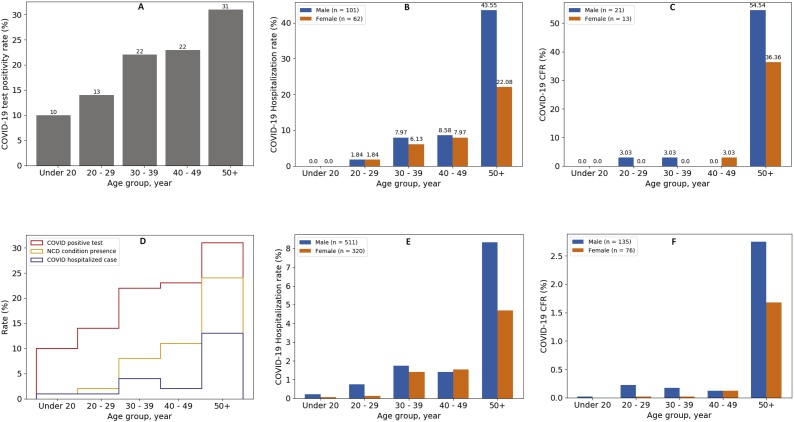
Empirical (Panels A–C) versus simulated (Panels D–F) distribution for age-specific percentages of hospitalizations and underlying conditions in a sample of COVID-19 cases. 10% of the total population was assumed to undergo testing, and stratified random sampling was applied to meet test positivity rates, as observed in Senegal. Hypothetical population sizes by age groups (under 20, 20–29, 30–39, 40–49 and 50+ years) were estimated for SARS-CoV-2 infections (422, 580, 899, 948, 1257, respectively), hospitalizations (11, 36, 129, 121, 534) and deaths (1, 10, 8, 10, 182).